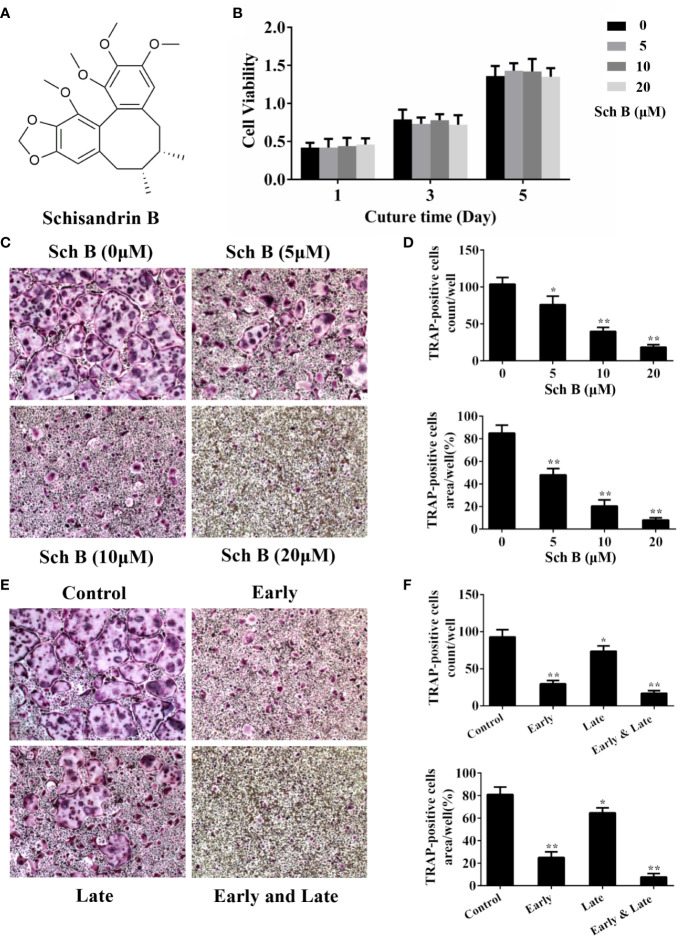
Schisandrin B inhibits osteoclast differentiation. (A) The chemical structure of Schisandrin B. (B) Bone marrow macrophages (BMMs) were treated with different concentrations of Schisandrin B (0, 5, 10, and 20 μM) for the indicated periods of time (1, 3, and 5 days). The cell viability was detected using CCK8 assay. (C, D) BMMs were treated with the indicated concentrations of Schisandrin B in the presence of macrophage colony stimulating factor (M-CSF) and receptor activator of nuclear factor-κB ligand (RANKL) for 5 days. TRAP-positive multinucleated osteoclasts were counted in the right column. (E, F) BMMs were treated with 20 μM Schisandrin B at early (1–3 days), late (3–5 days), and whole stages (1–5 days) of osteoclast differentiation in the presence of M-CSF and RANKL. TRAP-positive multinucleated osteoclasts were counted in the right column. The data were confirmed by three independent experiments and are expressed as means ± SD. *P < 0.05, **P < 0.01 versus the vehicle.